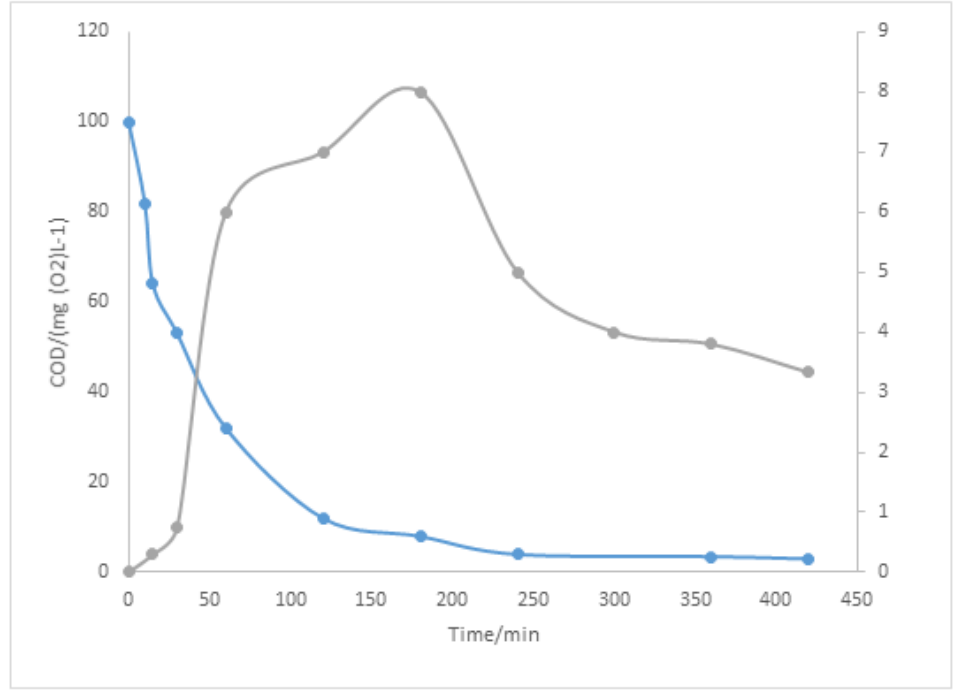
/COD ratio ( )) and mineralization evolution -COD- ( ), of the gentamicin, during the Figure 5: Biodegradability assessment (BOD 5 treatment by EF at I = 100 (mA /cm 2 ) and concentration of Fe 2+ of 0.1